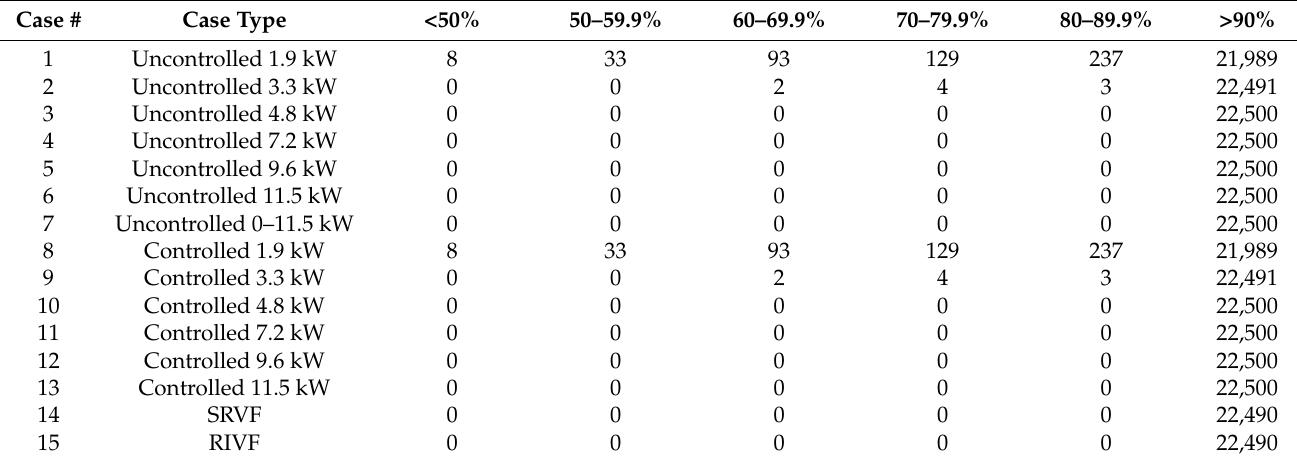
Table 6. Number of vehicles charged in each case.